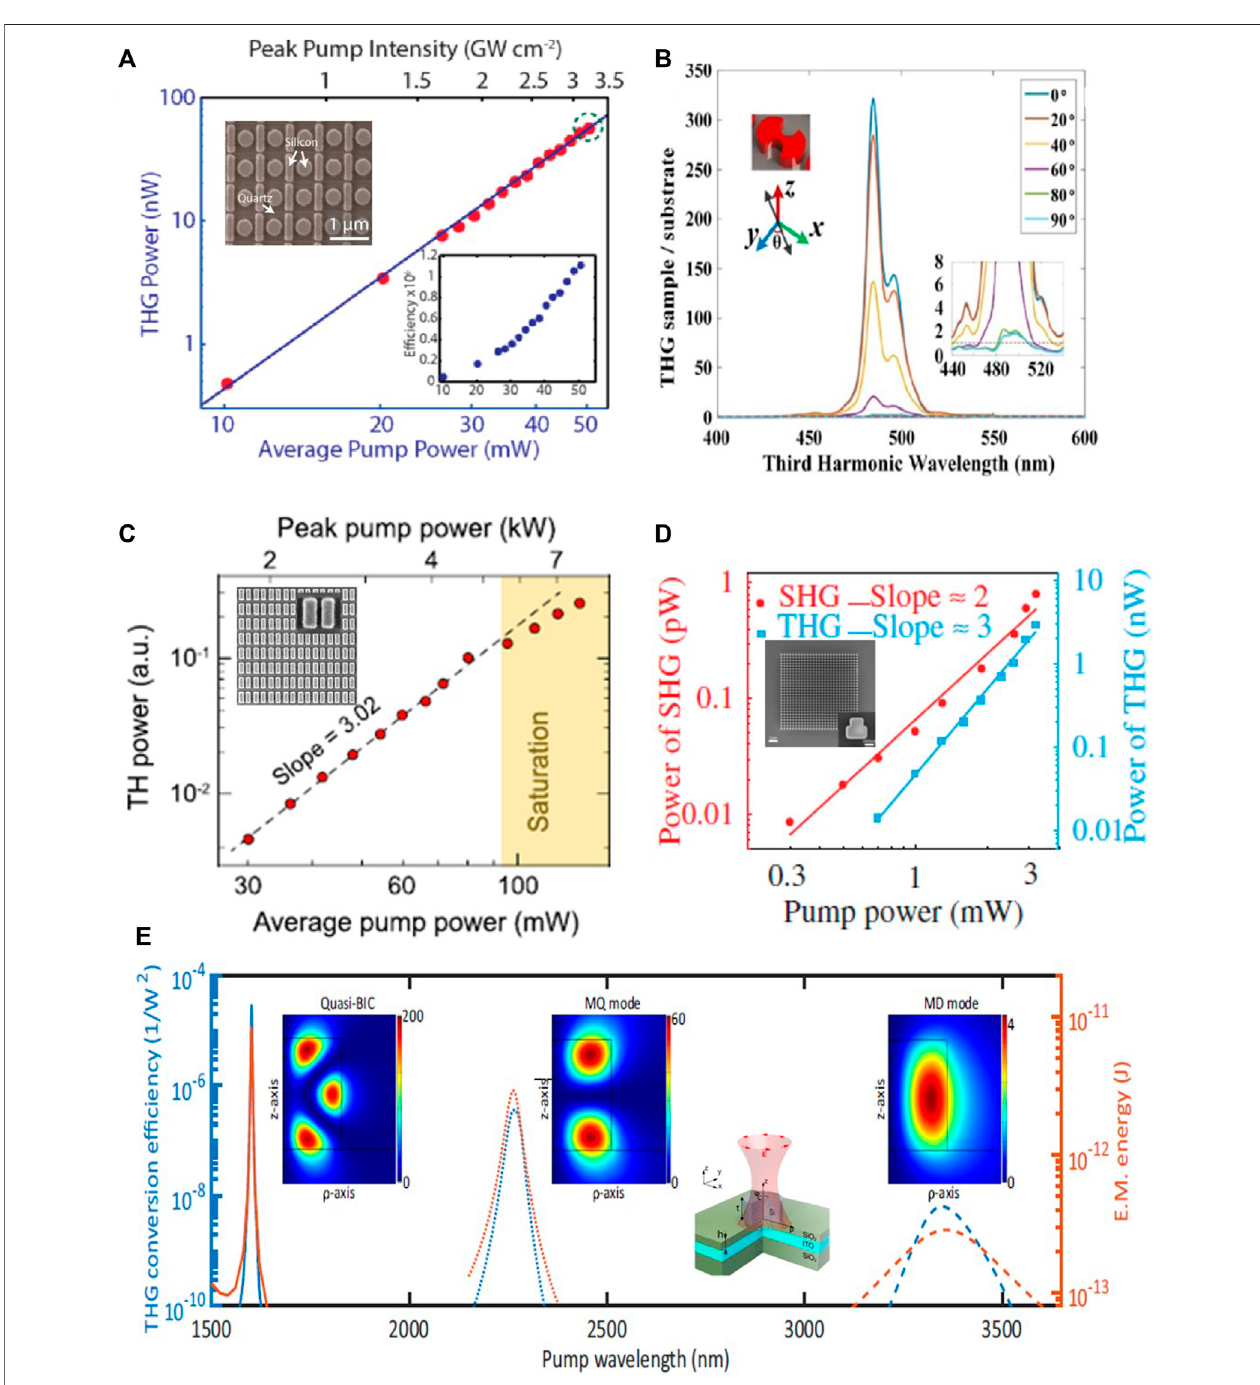
FIGURE3| NonlinearTHGprocessenhancementindielectricnanostructureswithdifferentresonancemodes. (A) TheFano-resonantSimetasurfacewithitsSEM image and the TH power as a function of the pump power (Yang et al., 2015). (B) The Si metasurface using trapped mode with THG spectra for different polarization angles (Tong et al., 2016). (C) Asymmetric Si metasurfaces associated with quasi-BIC modes and the dependence of the output TH power on the average and peak input power for the sample with α = 0.15 (Koshelev et al., 2019). (D) The high-Q quasi-BICs in Si metasurfaces with power dependences of SHG/THG in a logarithmic scale (Liu et al., 2019). (E) The Si disk resonator and the conversion ef fi ciency for THG as a function of the pump wavelength close to quasi-BIC, MQ mode, and MD mode (Carletti et al., 2019a).